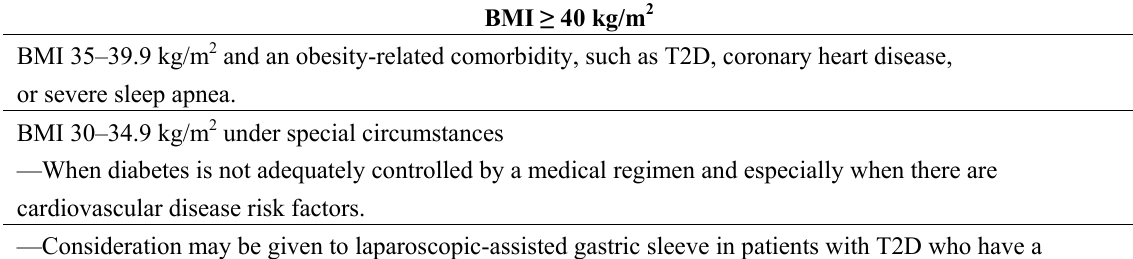
Table 8. Criteria for bariatric surgery for the management of obesity and/or diabetes